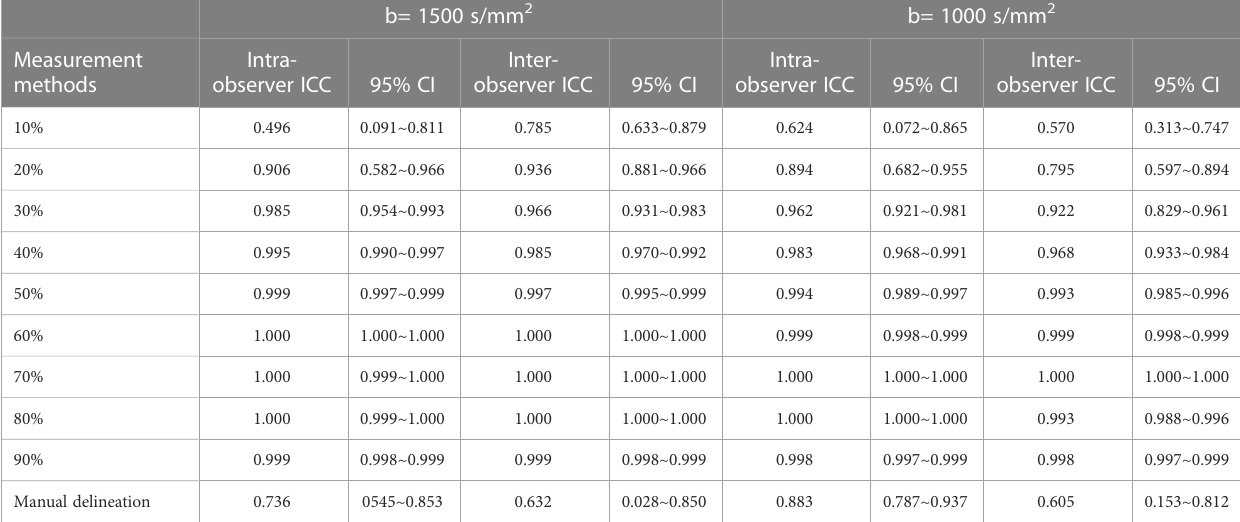
TABLE 1 Repeatability of semi-automatic delineation and manual delineation for measuring GTV